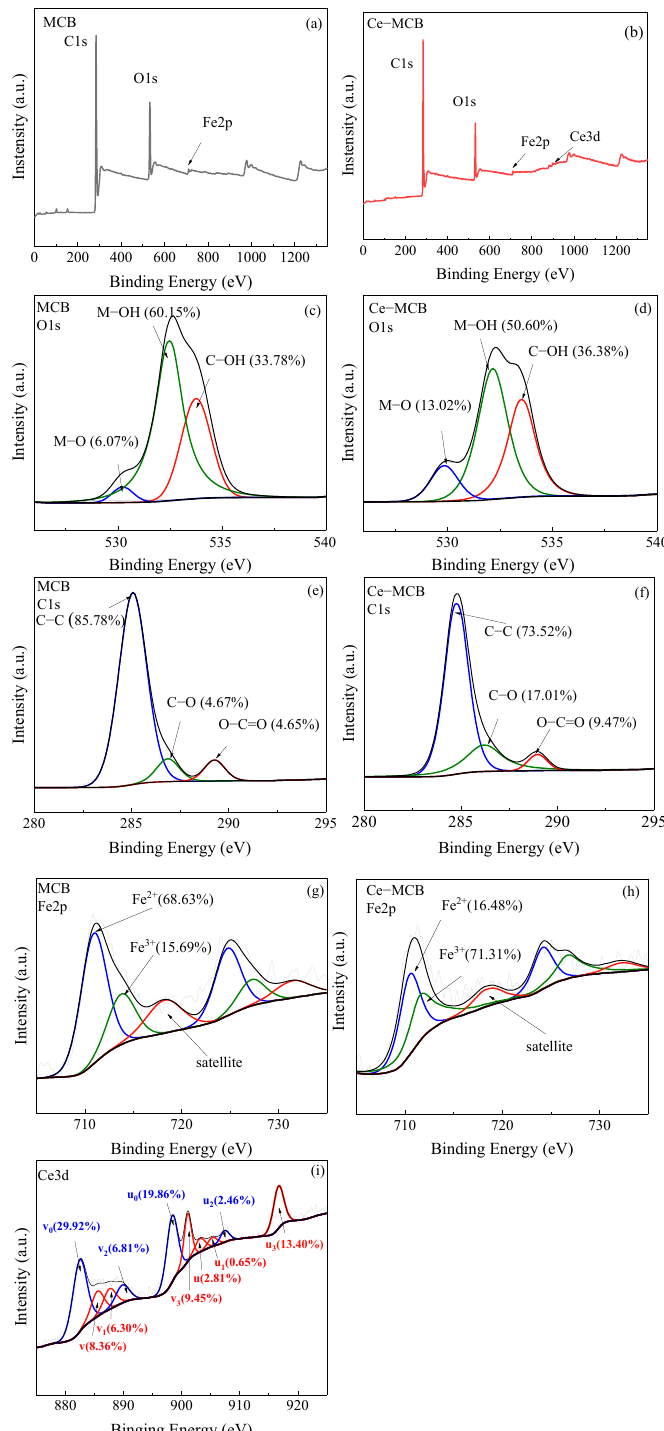
Figure 9. The XPS surveys of MCB and Ce-MCB ( a , b ). High-resolution XPS spectra of O1s ( c , d ), C 1 s ( e , f ), and Fe2p ( g , h ). Ce3d spectra of the Ce-MCB ( i